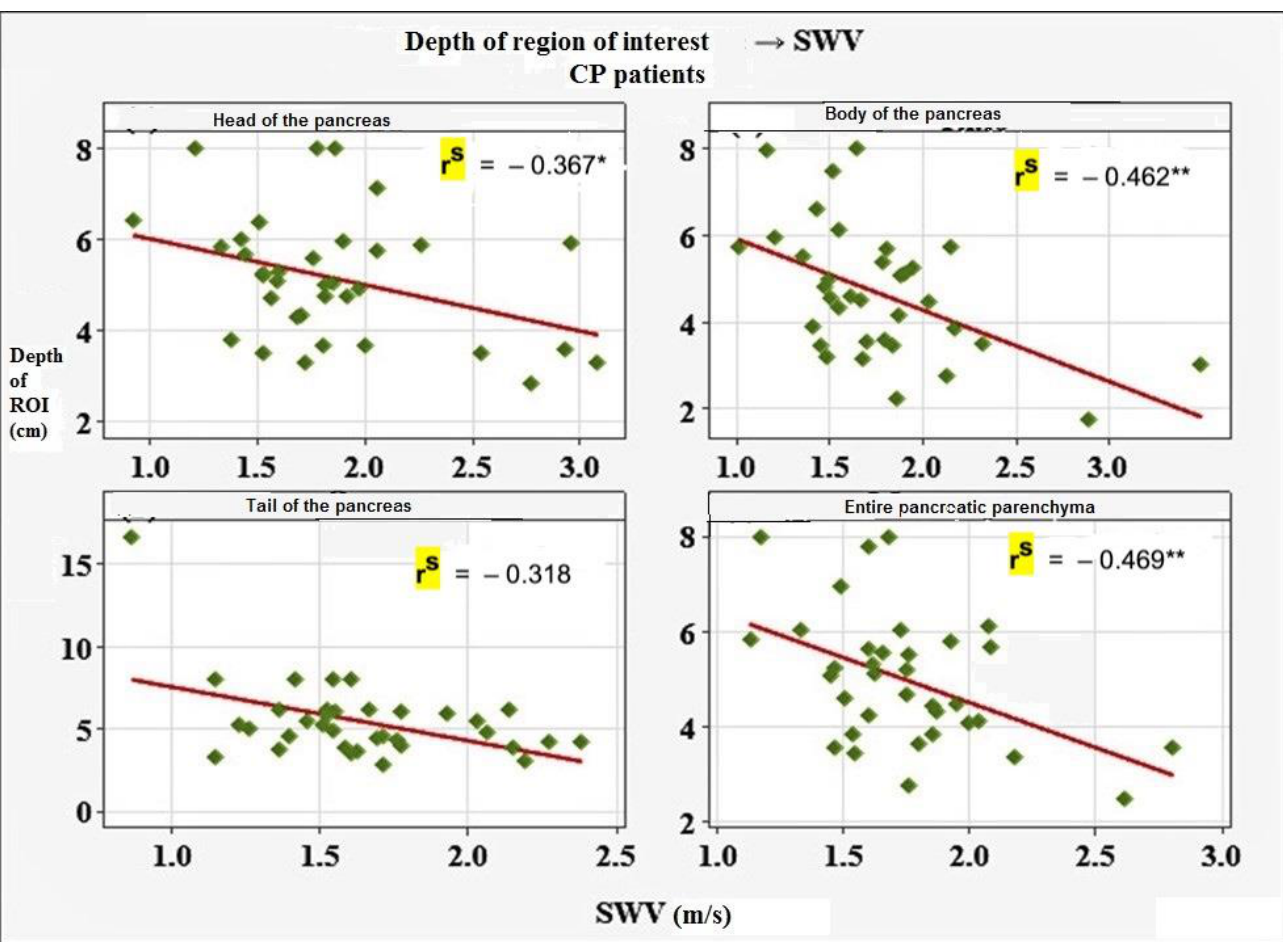
Figure 1. Association between depth of ROI and SWV in CP patients. *—significant association ( p < 0.05); **—significant association ( p < 0.01); rs—Spearman rank-order correlation (negative values re-flect inverse correlation).